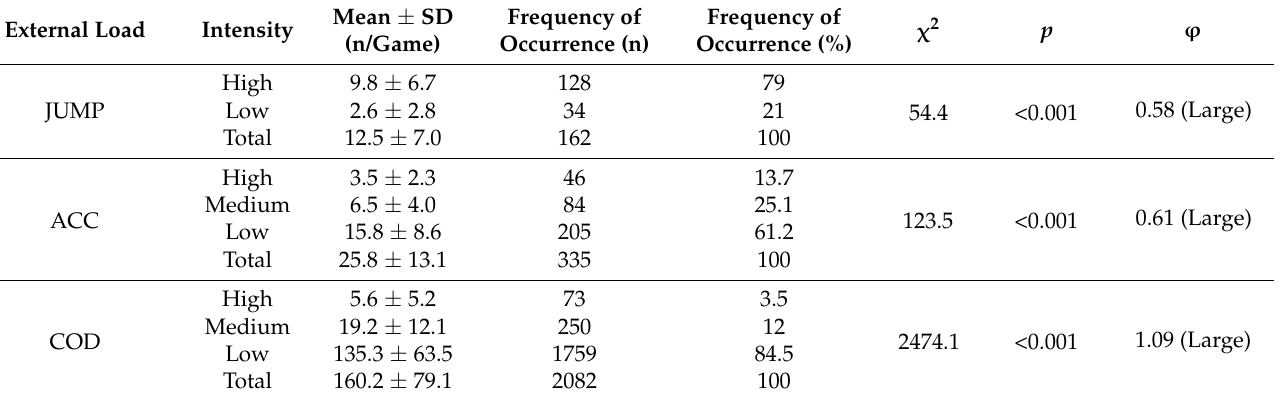
Table 1. Descriptive statistics and chi-square analysis for external load measures referred to game